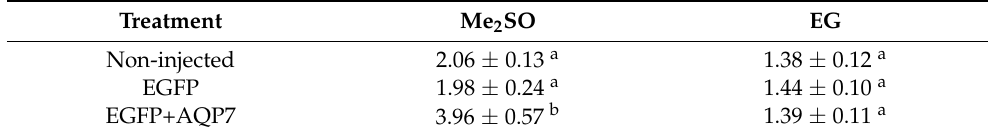
Table 4. Hydraulic conductivity ( L p ) of bovine oocytes injected with EGFP alone or EGFP + AQP7 cRNA exposed to HM medium containing 9.5% Me 2 SO or 8% EG at 25 ◦ C. Treatment